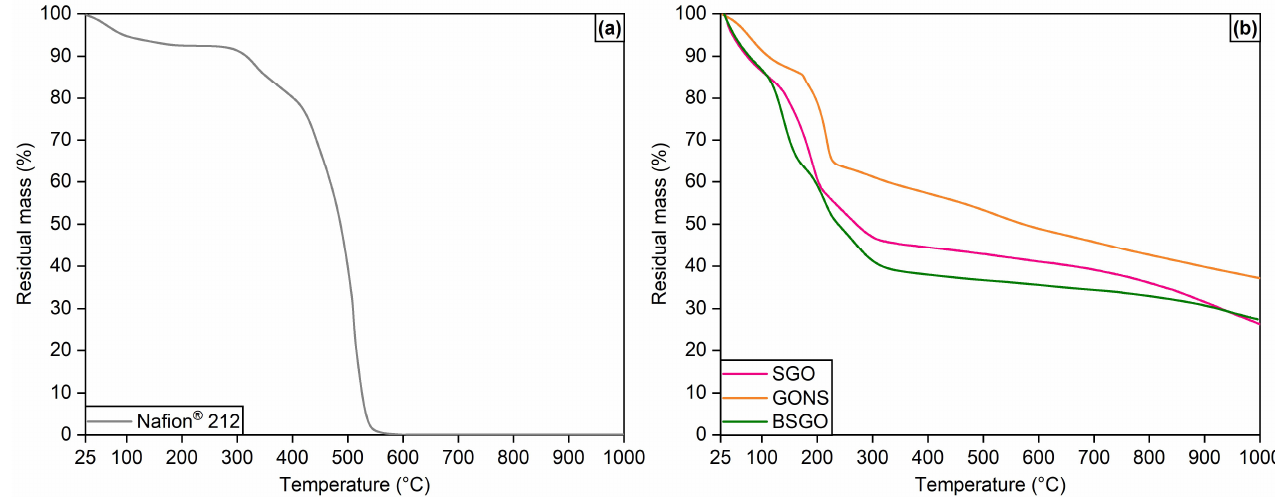
Figure 3. ( a ) Thermogram of Nafion ® 212; ( b ) Thermograms of the proposed GO-based membranes. Cross-sectional SEM images at 1000 × magnification of the GO-based